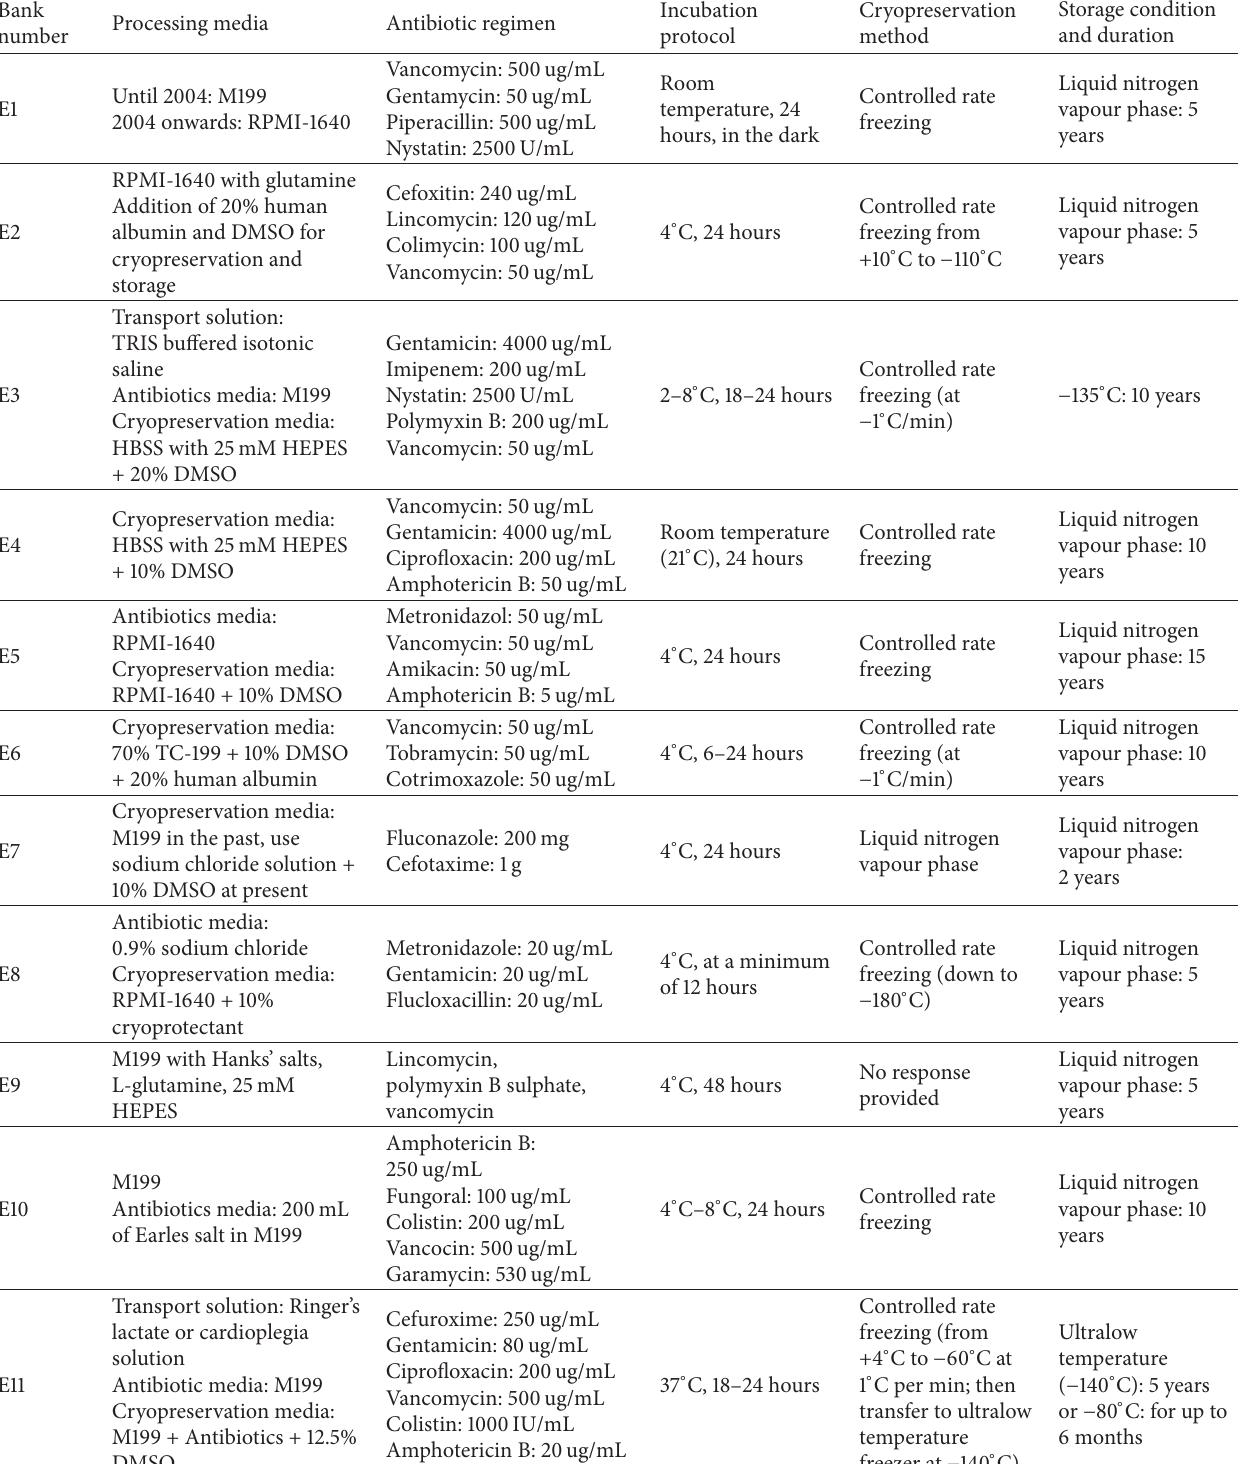
Table 1: Summary of heart valve processing protocols used by HVBs in